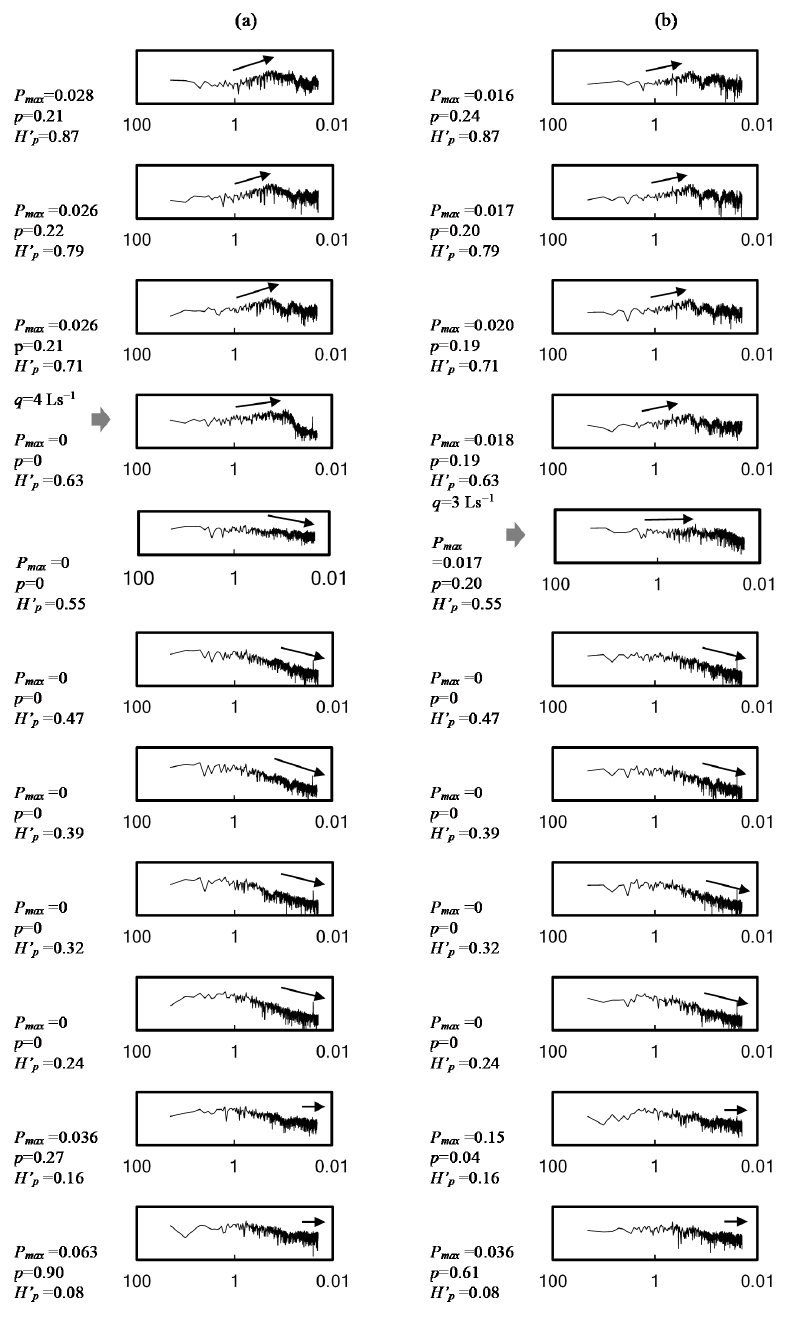
Figure 7. Energy spectrum density examples of air pressure along with a stack (measurement time = 20.48 s). ( a ) Discharge at H’ = 0.63 at a flow rate of 4 Ls − 1 ; ( b ) discharge at H’ = 0.55 at a flow rate of 3 Ls − 1 .